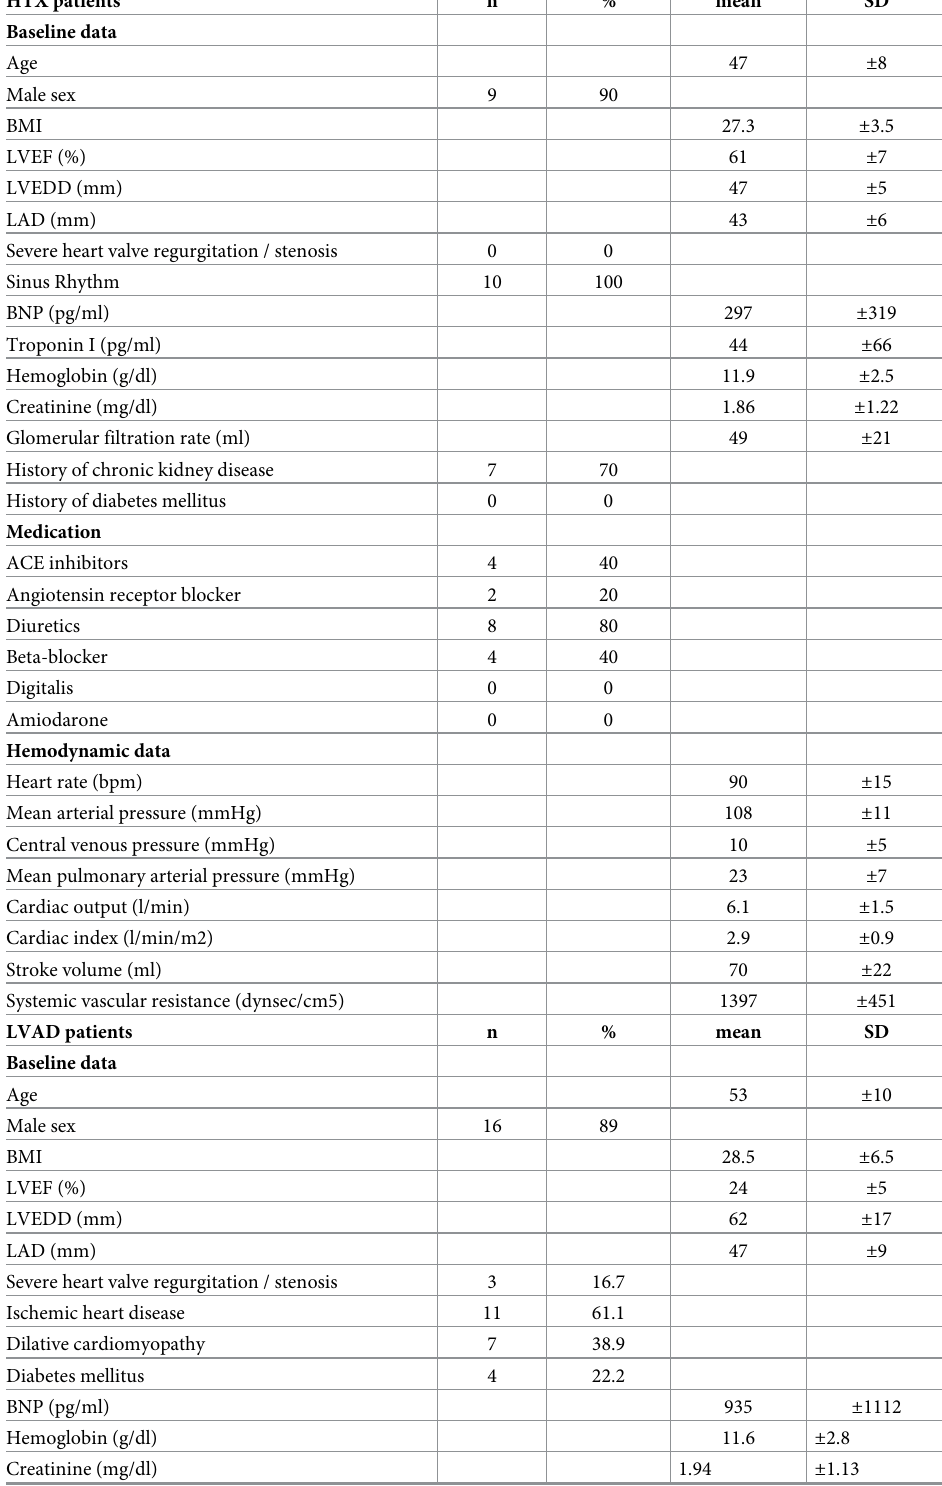
Table 1. Patient characteristics HTX and LVAD